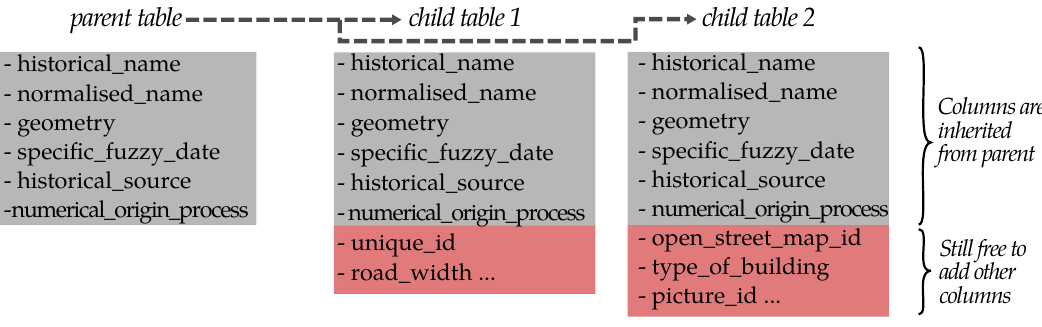
Figure 5. The table inheritance mechanism: a child table inheriting from a parent table inherits all the parent columns, and can also have its own. However, the parent table also virtually contains all the content of the child